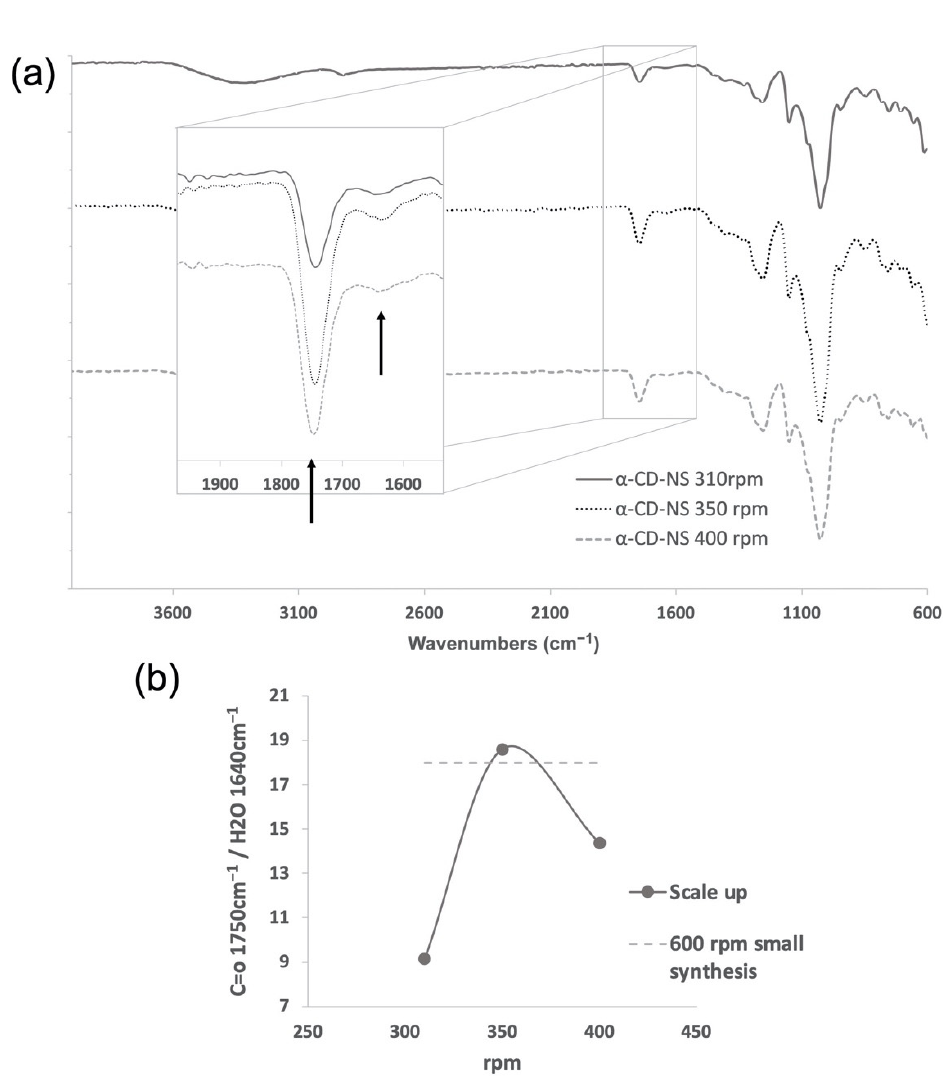
Figure 6. Analysis of α -CD-NS mechanochemical (ball mill) synthesis scale-up at 310, 350, and 400 rpm using a 500 mL zirconia jar: ( a ) FTIR-ATR spectra of α -CD-NS obtained with arrows indicating the band of interest at around 1750 cm − 1 assignable to the carbonyl group of the ester bond and the band at 1640 cm − 1 assignable to bending of the adsorbed water. ( b ) Carbonyl band (1750 cm − 1 ) and water bending band (1640 cm − 1 ) area ratio.